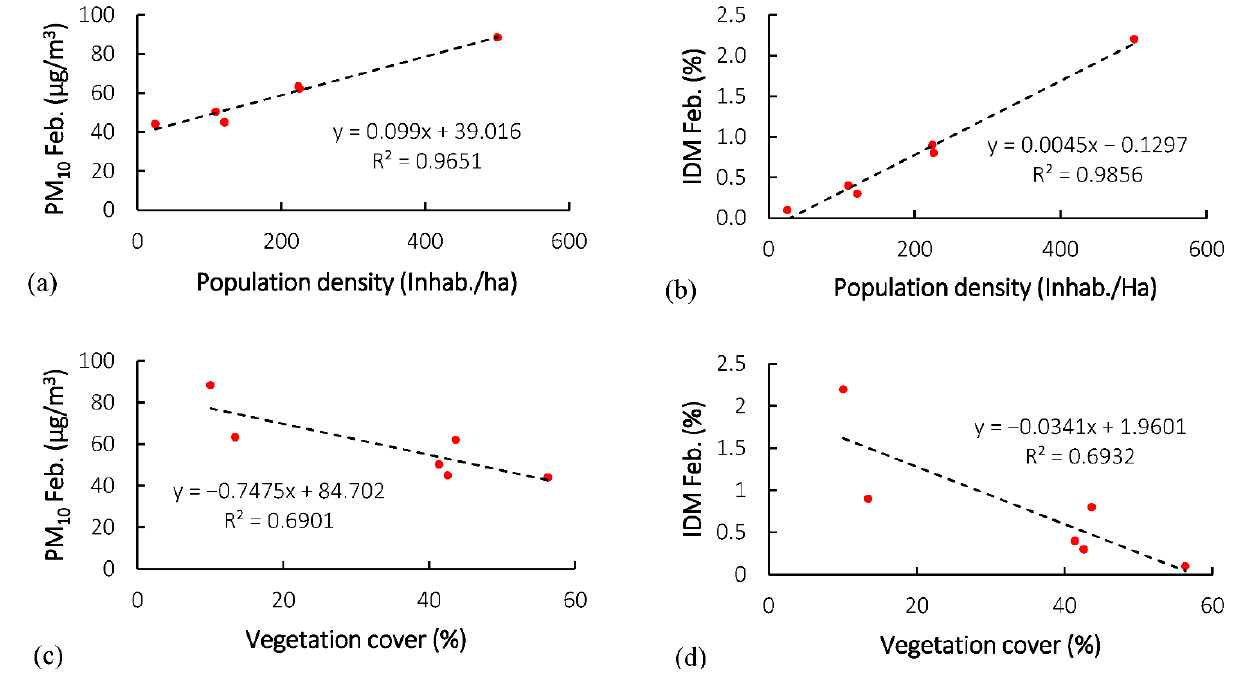
Figure 8. Linear regression models (radius = 800 m) for the following relationships in February: ( a ) population density and PM 10 , ( b ) population density and IDM, ( c ) vegetation cover and PM 10 , and ( d ) vegetation cover and IDM.